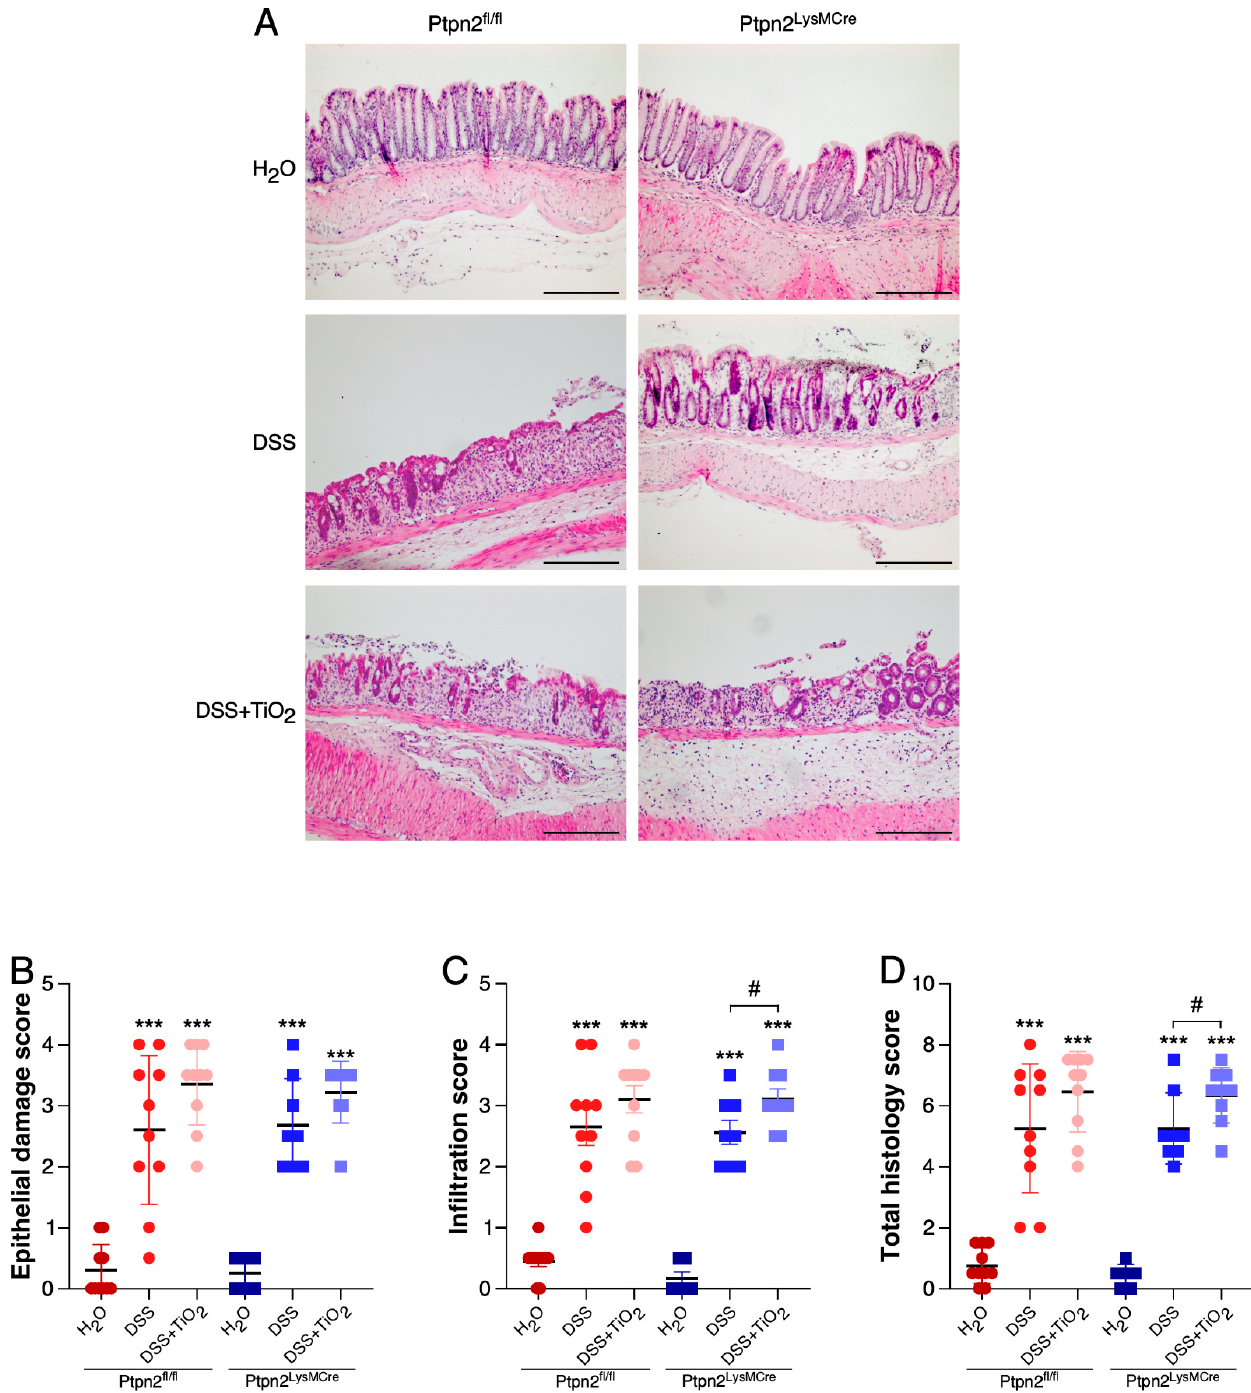
Figure 2. Loss of Ptpn2 in myeloid cells exacerbates TiO 2 effects at histological level. ( A ) Representative histology images of Ptpn2 fl/fl and Ptpn2 LysMCre mice during DSS-acute colitis under the indicated treatments. ( B ) Epithelial damage scoring in Ptpn2 fl/fl and Ptpn2 LysMCre mice during DSS-acute colitis under the indicated treatments. ( C ) Infiltration scoring in Ptpn2 fl/fl and Ptpn2 LysMCre mice during DSS-acute colitis under the indicated treatments. ( D ) Total histology scoring in Ptpn2 fl/fl and Ptpn2 LysMCre mice during DSS-acute colitis under the indicated treatments. Data shown in panels ( B – D ) represent mean ± SD. *** p ≤ 0.001 relative to H 2 O of the same genotype. # p ≤ 0.05 relative to DSS of the same genotype. Scale bar: 100 μ m.